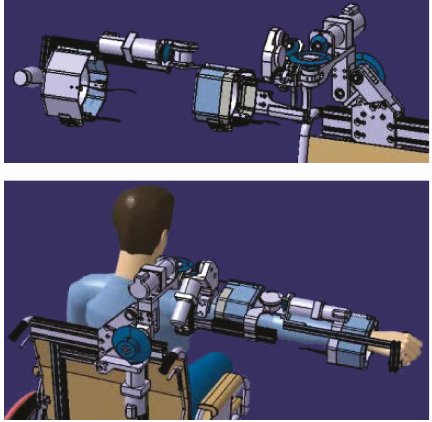
Figure 1: Exoskeleton design developed by Moubarak et al.